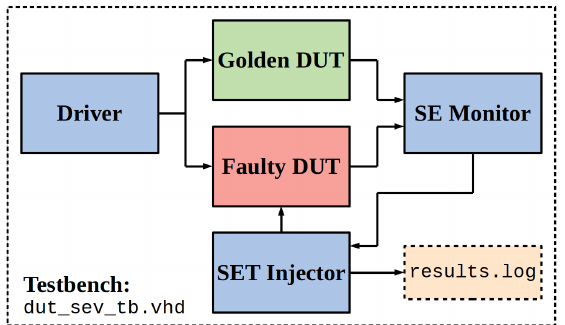
Figure 1. Proposed simulation framework for Soft-Error Vulnerability (SEV) estimation. It is a VHDL Testbench file that enables Single-Event Transient (SET) injection and Soft Error (SE) detection comparing the results of two versions of the Design Under Test (DUT), while running the same operational